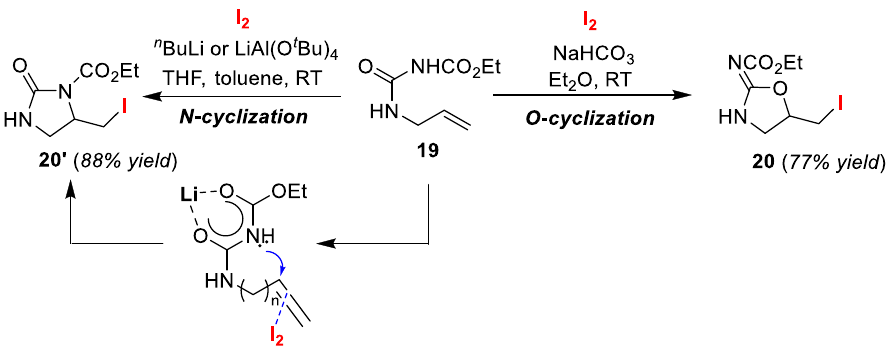
Figure 11. O/N atom-selective iodo-cyclizations of olefinic carbamates 19 . Figure 11. O / N atom-selective iodo-cyclizations of olefinic carbamates 19 .